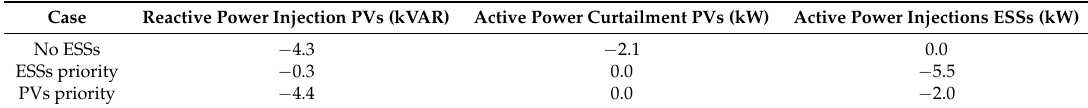
Table 2. Summary of the simulation